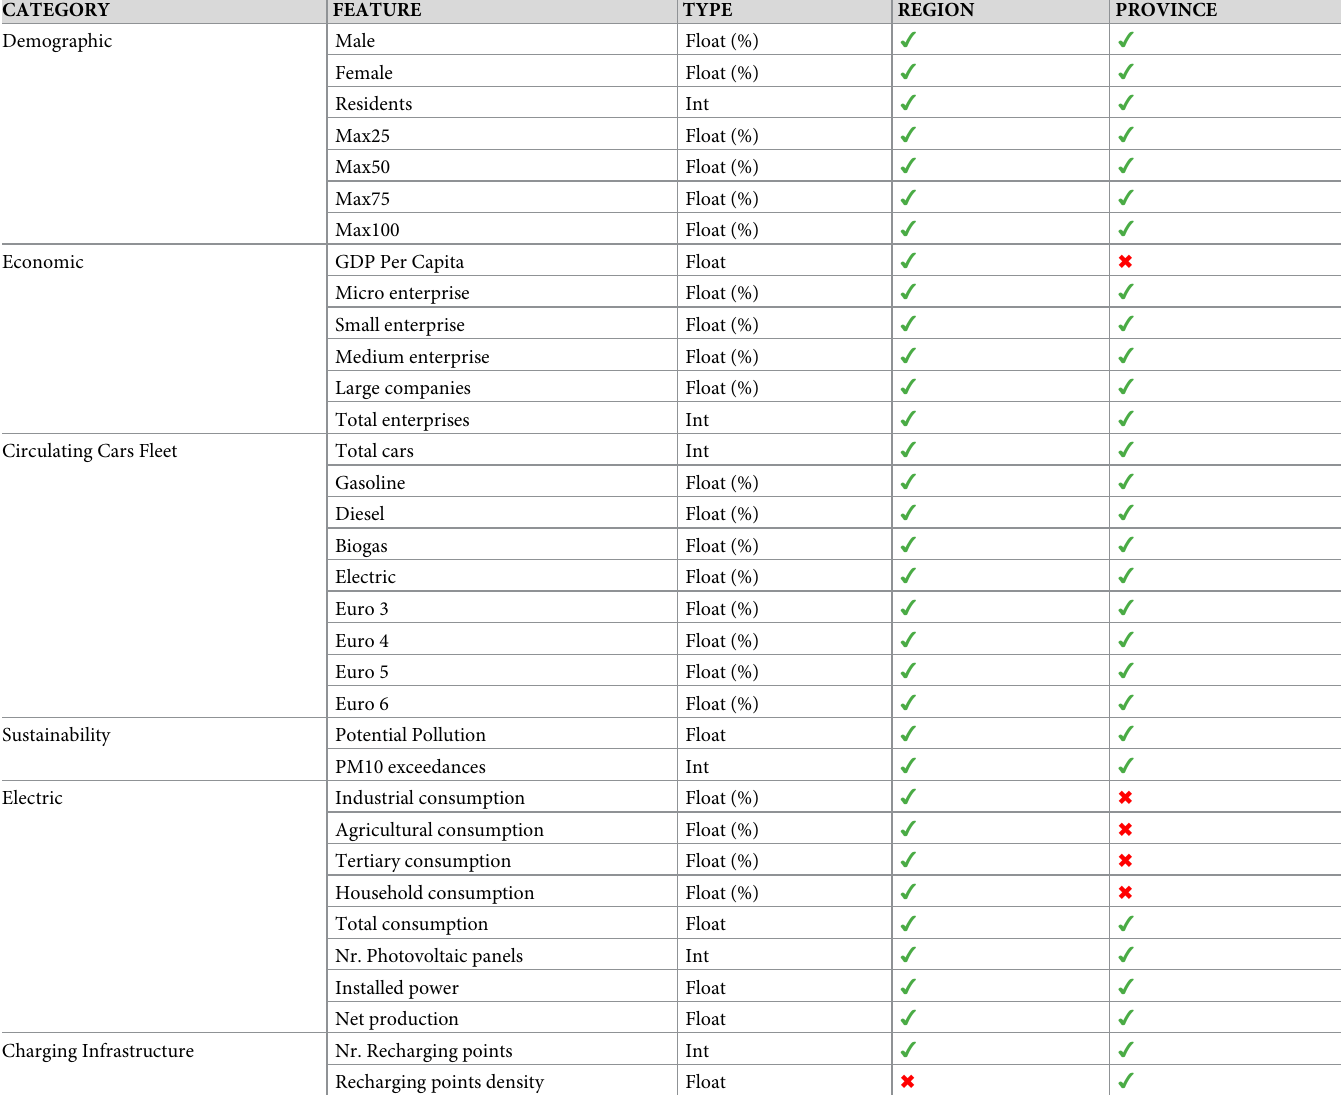
Table 1. Describing features types, divided for category which have been collected in our data collection process. CATEGORY